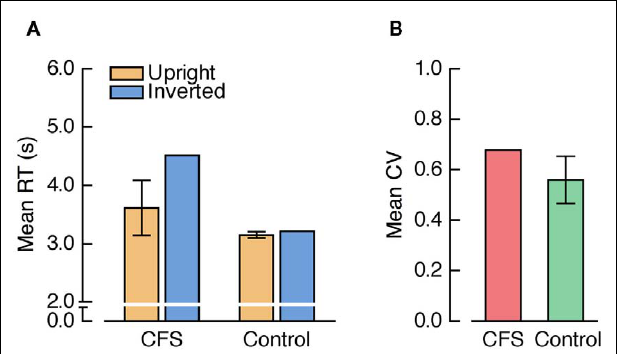
FIGURE 12 | (A) Mean RTs and (B) mean CVs from Experiment